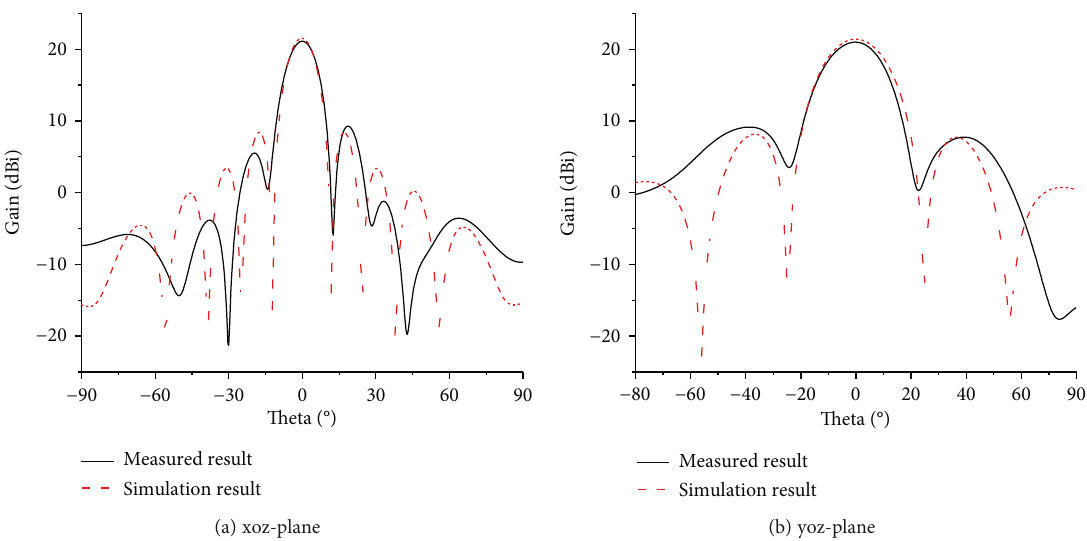
Figure 17: Comparisons of the measured and simulation radiation patterns of the prototype at 5.8GHz.